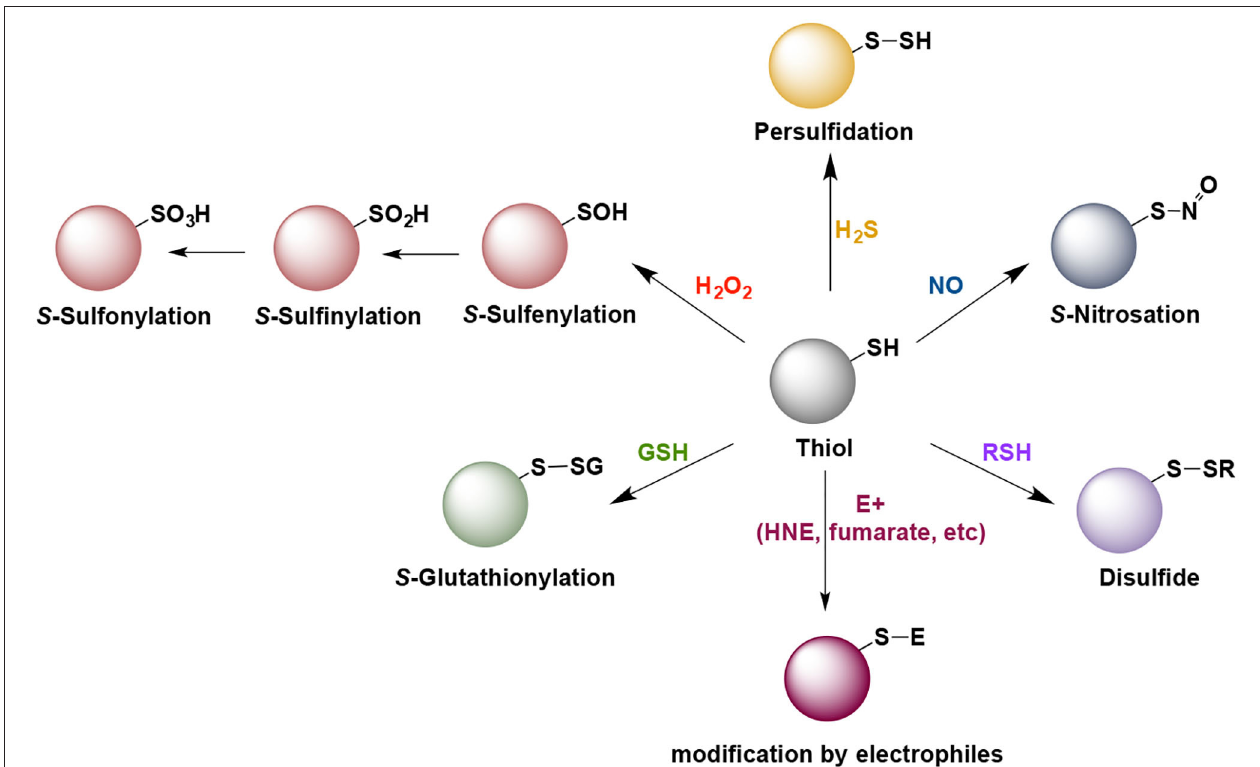
FIGURE 1 | Some of the naturally occurring posttranslational modification of cysteine residues that play role in cell signaling and pathogenesis of neurodegenerative diseases. Note that with the exception of the H 2 O 2 and intracellularly generated electrophiles (E + ), all other reactions do not proceed directly and require an intermediate oxidation